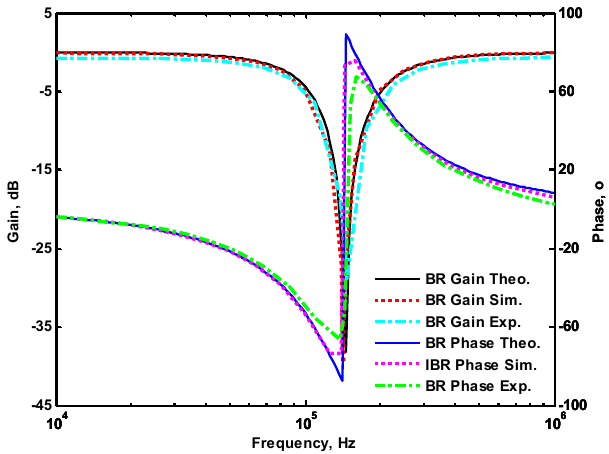
Figure 8. Experimental and simulated inverted band-pass (IBP) filters with theoretical responses.